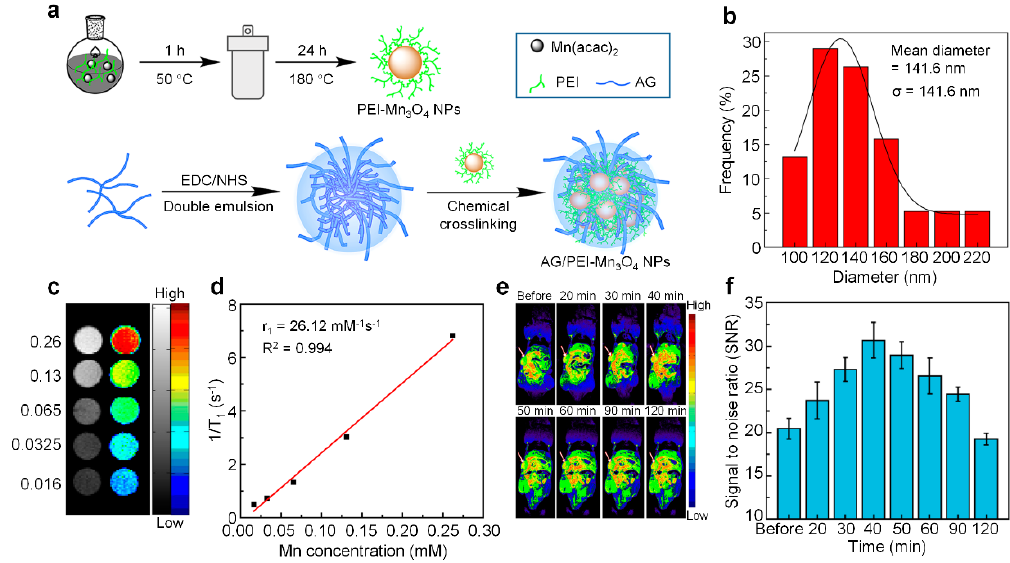
Figure 7. ( a ) Schematic illustration of preparation of AG/PEI-Mn 3 O 4 NPs. ( b ) Size distribution histogram of AG/PEI-Mn 3 O 4 NPs. ( c ) T 1 -weighted MRI images of AG/PEI-Mn 3 O 4 NPs under different concentrations. ( d ) Linear fitting of 1/T 1 with Mn concentration of AG/PEI-Mn 3 O 4 NPs. ( e ) In vivo MRI images of U87MG xenografted tumor bearing mice at different time points post-injection of AG/PEI-Mn 3 O 4 NPs. ( f ) Signal-to-noise ratio (SNR) of tumor area at different time points calculated from MRI images in ( e ). Adapted from [68]. Copyright© 2018 American Chemical Society.